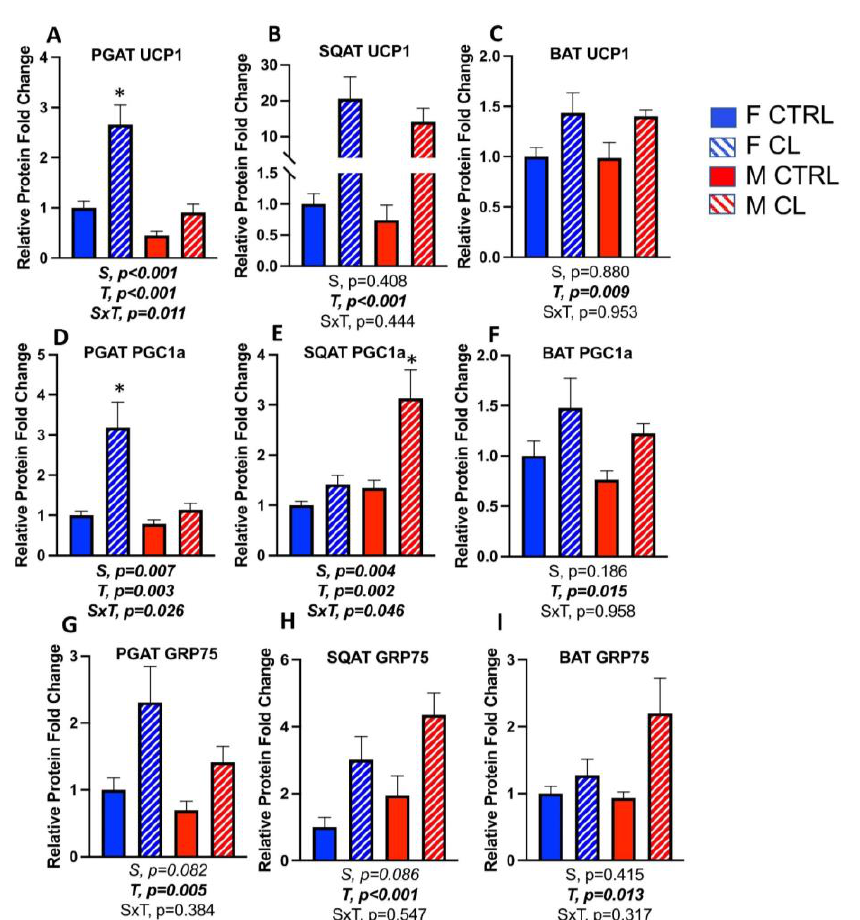
Figure 6. Male (M) and female (F) C57BL/6J mice, all on HFD, were treated for 2 weeks with daily CL injections (1 μg/g body weight) or CTRL (saline). Perigonadal (PGAT), subcutaneous (SQAT) and brown (BAT) adipose tissue depots were collected and the expressions of browning markers were measured via Western blot. ( A ) PGAT Uncoupling protein 1 (UCP1); ( B ) SQAT UCP1; ( C ) BAT UCP1; ( D ) PGAT PPAR-gamma coactivator 1 alpha (PGC1a); ( E ) SQAT PGC1a; ( F ) BAT PGC1a; ( G ) PGAT glucose related protein 75 (GRP75); ( H ) SQAT GRP75; ( I ) BAT GRP75. Blot intensity relative to beta actin was calculated. All data are presented as mean ± SEM, relative to the F CTRL. N = 7–9/group. Main effects of sex (S), CL treatment (T) and sex by treatment interactions (S × T) were determined by 2 × 2 ANOVA and are presented below the respective figures. p -value < 0.05 accepted as significant. * statistically different from all other groups as determined by Tukey’s post-hoc test.